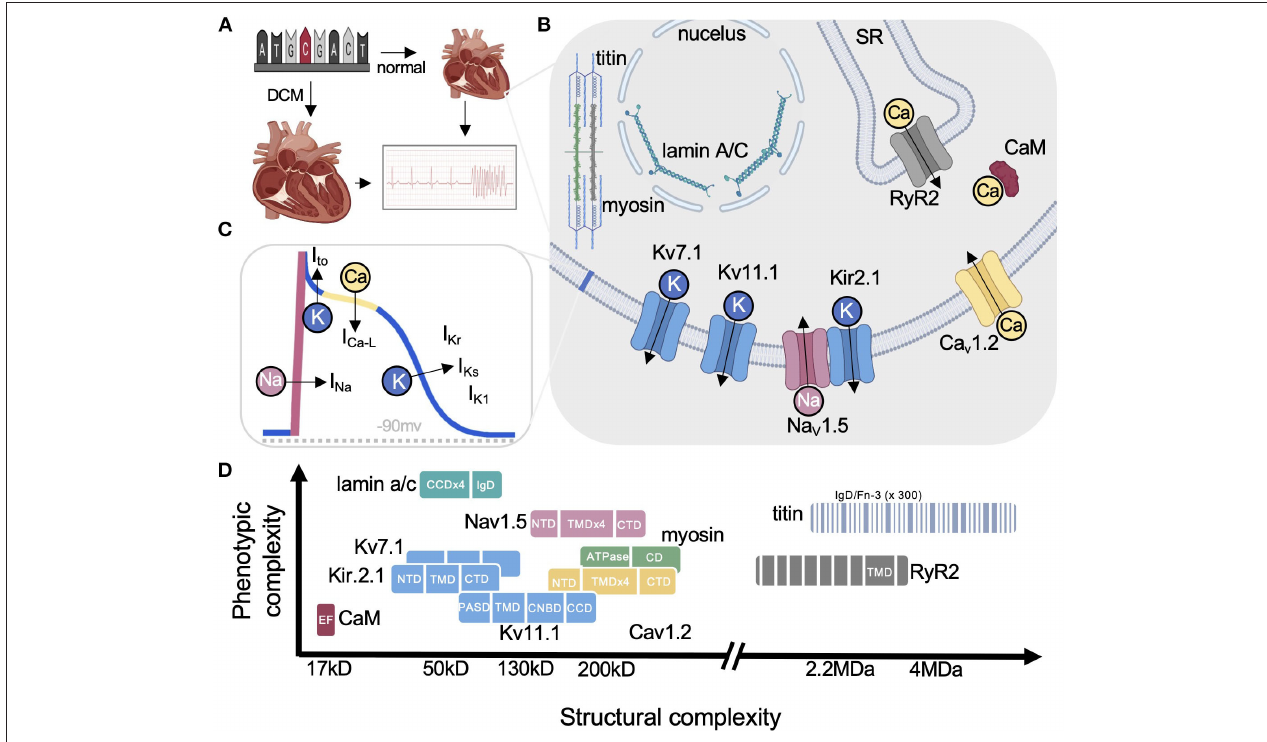
FIGURE 1 | Cardiac disease proteins highlighted in this review. (A) Arrhythmias can result from structurally abnormal hearts (e.g., DCM) or normal hearts with electrical abnormalities (e.g., LQTS). (B) Simplified cartoon highlighting each protein and their primary functions. (C) Ventricular action potential showing the major ionic currents. (D) Graph illustrating the range in size for each protein discussed on the x-axis from small calmodulin to the the largest human protein titin comprised of hundreds of small soluble domains (eg., IgD). The y-axis shows the relative pleiotropy for each gene (i.e., relative number of diseases associated with each). For example, CaM has only been linked to LQTS while lamin underlies over a dozen diseases. Nav1.5 on the other hand is a good example of pleiotropy among the ion channels reviewed by Cerrone et al. ( 3) with lamin being the most pleiotropic. DCM, dilated cardiomyopathy; SR, sarcoplasmic reticulum; RYR2, ryanodine receptor 2; CaM, calmodulin; CCD, coiled-coil domain; CD, converter domain; IgD, immunoglobulin-like domain; NTD, FN-3, fibronectin type III-like; N-terminal domain; TMD, transmembrane domain; PASD, PerArntSim domain; CNBD, cyclic nucleotide-binding homology domain. Some figure panels created with